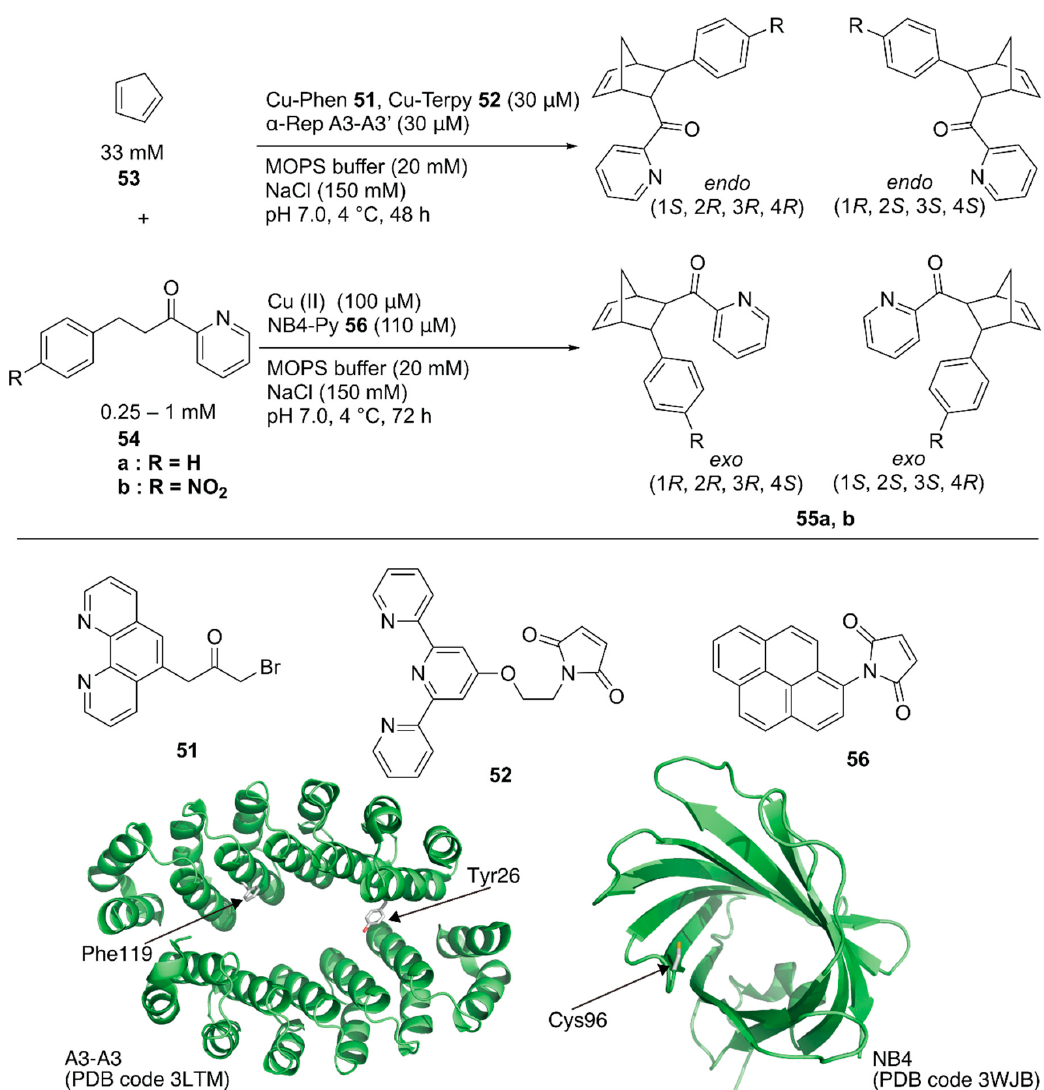
Figure 10. Artificial copper enzymes as catalysts for the Diels–Alder reaction. Adapted from [79,83].